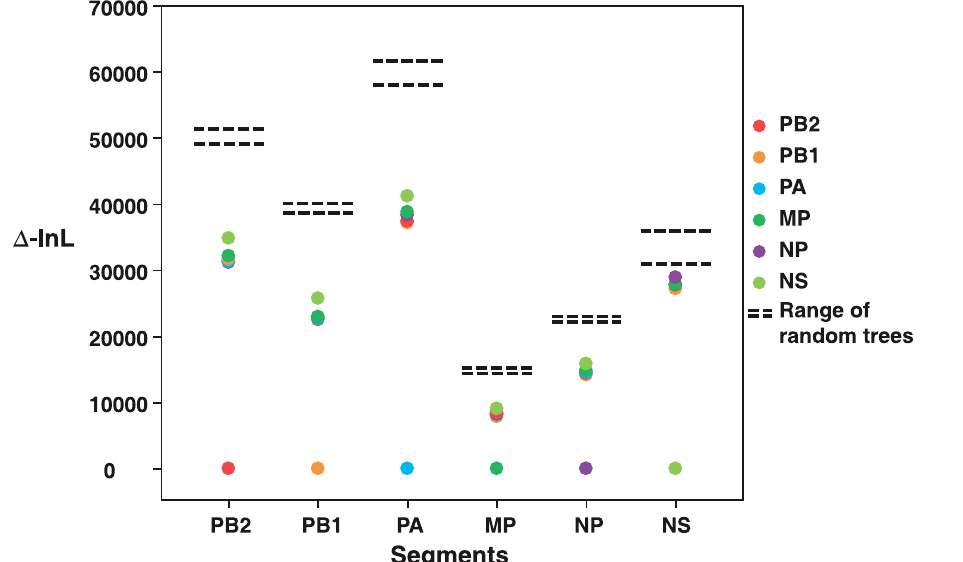
Figure 3. Maximum likelihood analysis of congruence among the internal gene segments of 407 isolates of avian influenza virus. Each column represents the difference in log likelihood ( D -lnL) between the ML trees of each gene (shown by colored dots). In every case, the ML tree estimated for the reference gene has the highest likelihood, while lower likelihoods (greater D -lnL values) are observed when the ML trees for the other genes are fitted to the sequence data from the reference gene and branch lengths re-optimized. To assess the extent of similarity in topology among genes, 500 random trees were created for each data set and their likelihoods assessed for each gene in turn using the same procedure (indicated by horizontal bars). In every case, and most notably for NS, the trees inferred for each gene have likelihoods closer to the random set than to the ML tree for the reference gene, indicative of extensive incongruence.